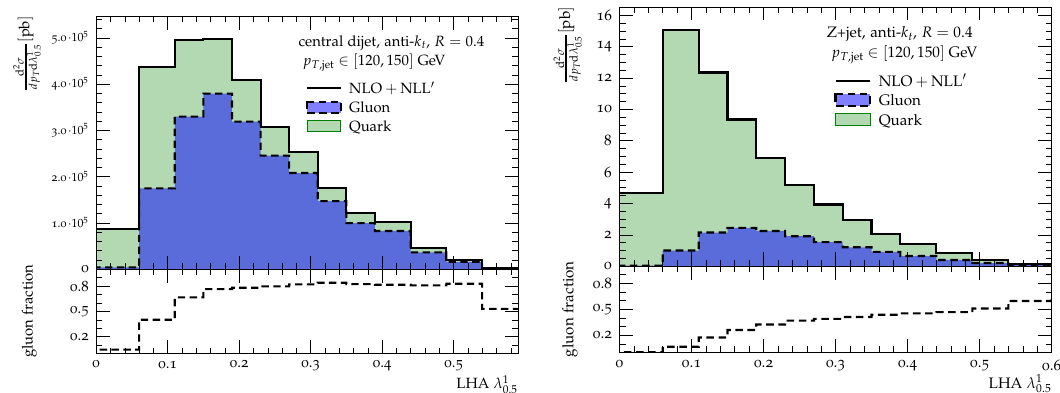
Figure 8. NLO + NLL 0 accurate predictions for the quark- and gluon-jet contribution to the Les Houches Angularity λ 1 for the central dijet (left) and the Z +jet (right) event selections, with jets 0 . 5 in the range p T, jet ∈ [120 , 150] GeV. The lower panels show the gluon fractions in the respective angularity